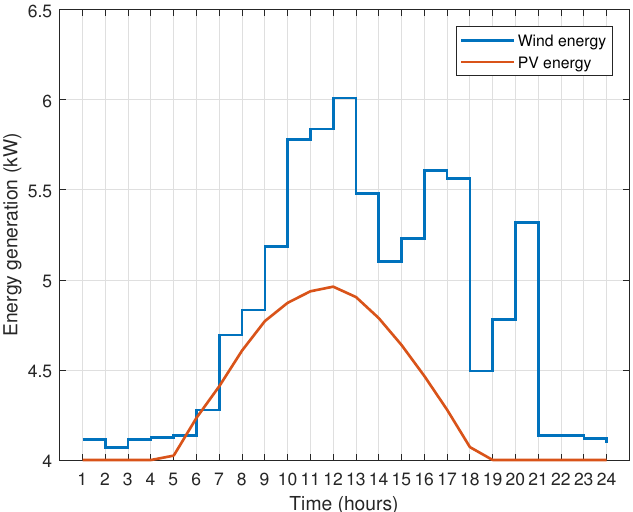
Figure 12. Microgird including PV and WT energy generation.